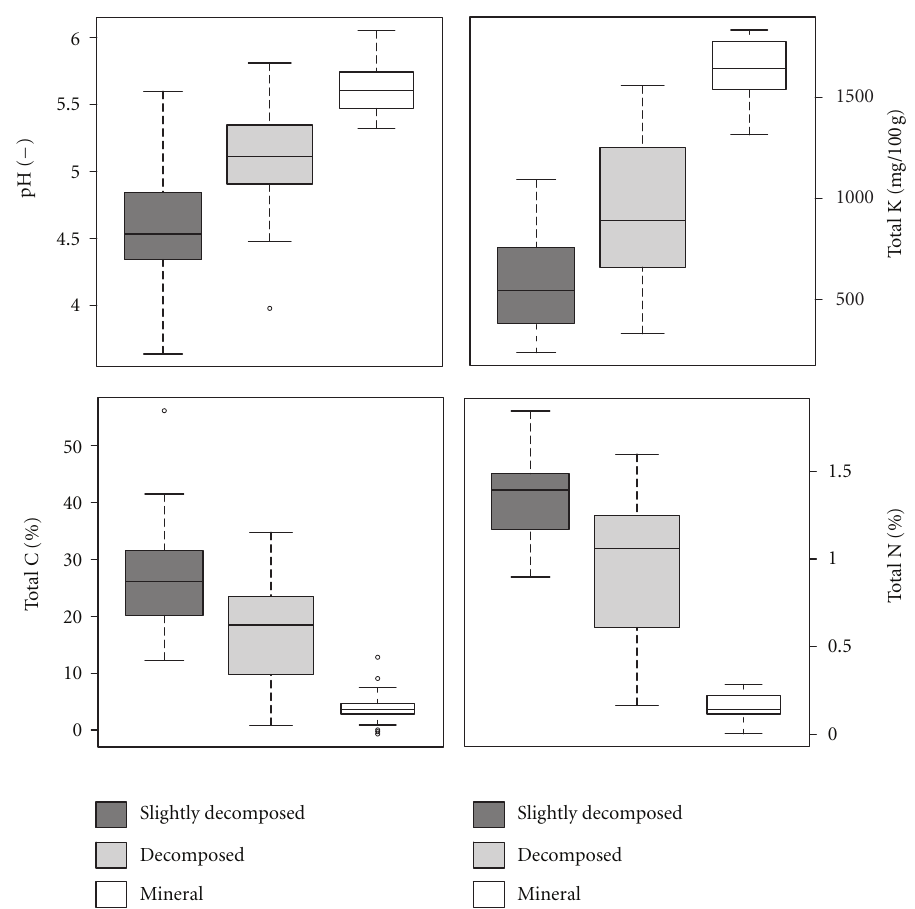
Figure 6: Boxplots for pH, total K, total C, and total N, based on PLSR (pH and K) and SMLR (C and N) estimated soil properties, for all the